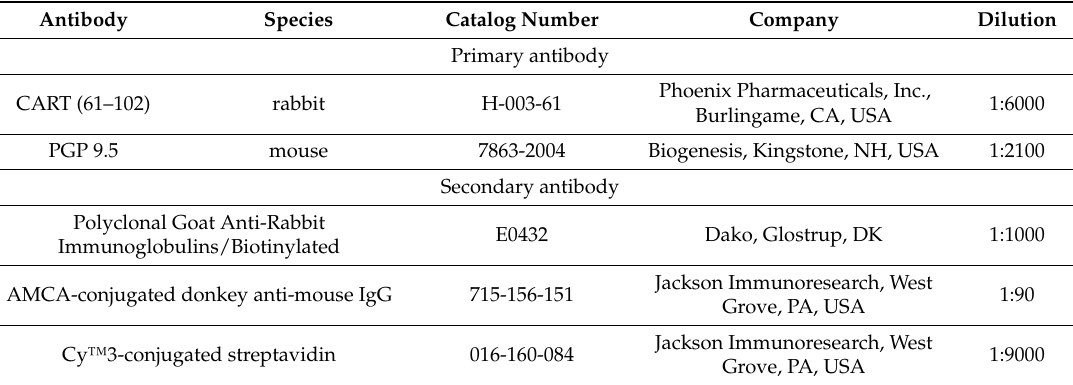
Table 3. Characteristic of the antibodies used for double-immunofluorescence staining. Antibody Species Catalog